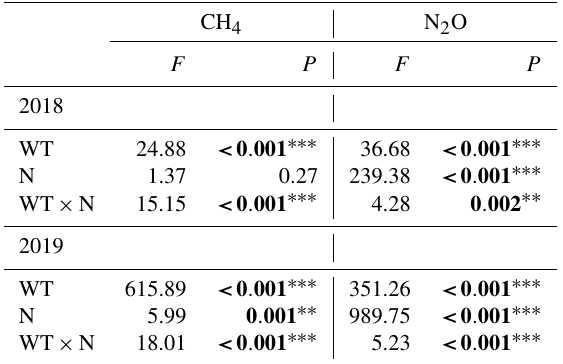
Table 3. The individual and interactive effects of water table (WT) and nitrogen (N) deposition levels on cumulative CH 4 and N 2 O emissions in 2018 and 2019 using generalized least square (GLS)